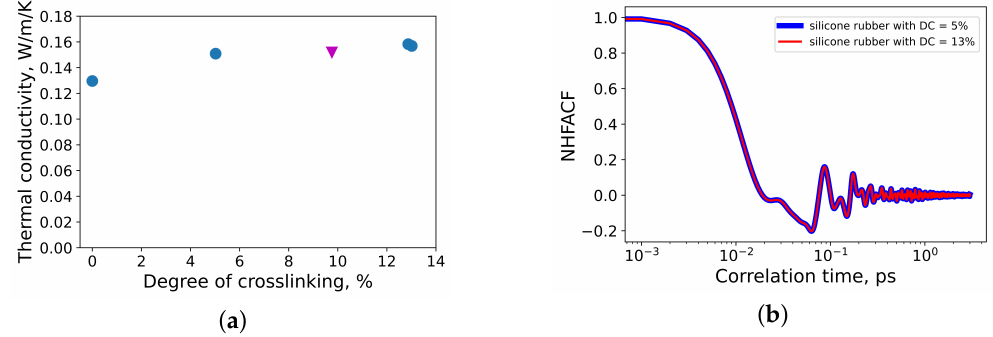
Figure 6. ( a ) Thermal conductivity of silicone rubber as a function of the degree of crosslinking. For comparison, the data point corresponding to the degree of crosslinking 9.8 % (red triangle) from Ref. [29] is shown; ( b ) Normalized heat flux autocorrelation function (NHFACF) as function of correlation